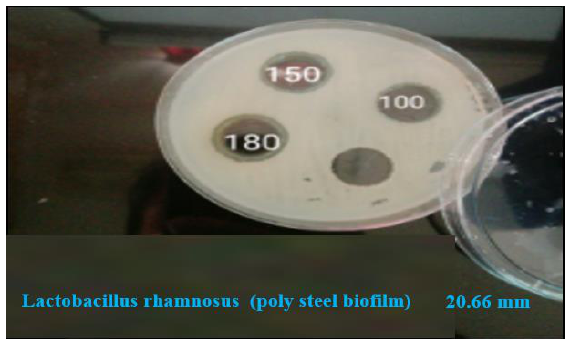
Fig. 6. Results of inoculation of L. rhamnosus suspension on P. aeruginosa biofilm at different levels